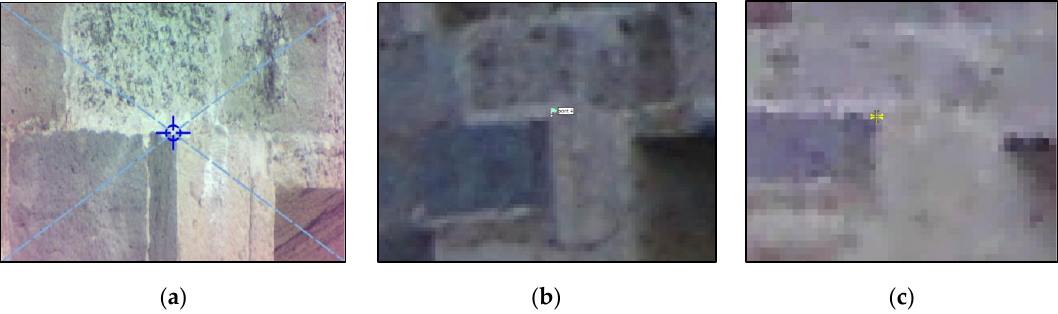
Figure 15. The same control point as appearing: ( a ) the total station image; ( b ) one photogrammetric image; ( c ) the TLS point cloud.